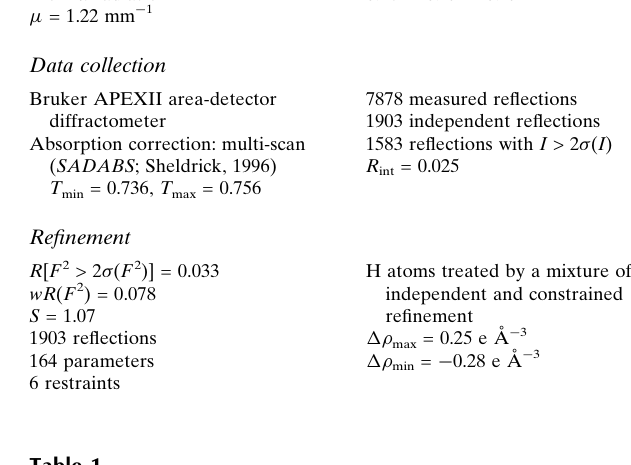
Hydrogen-bond geometry (A˚ , (cid:2)